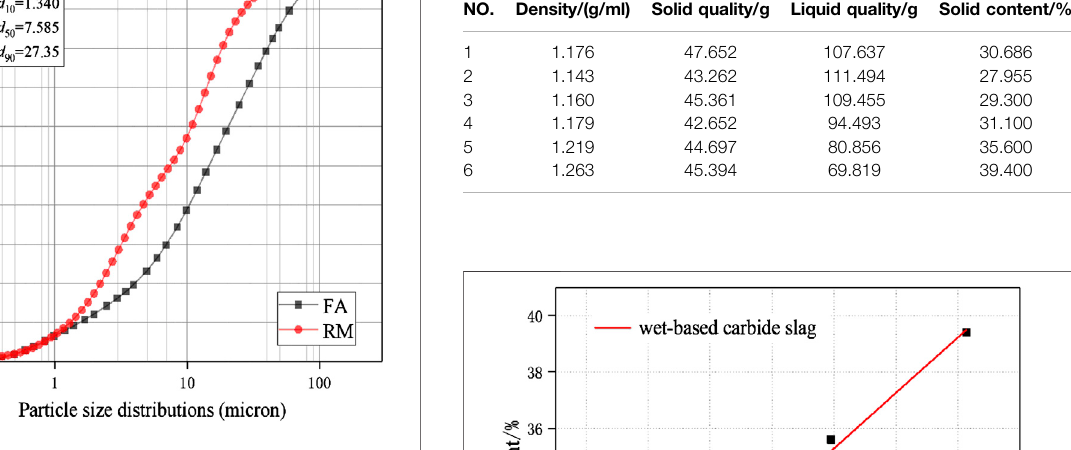
FIGURE 4 | Particle size distributions of red mud and fl y ash.